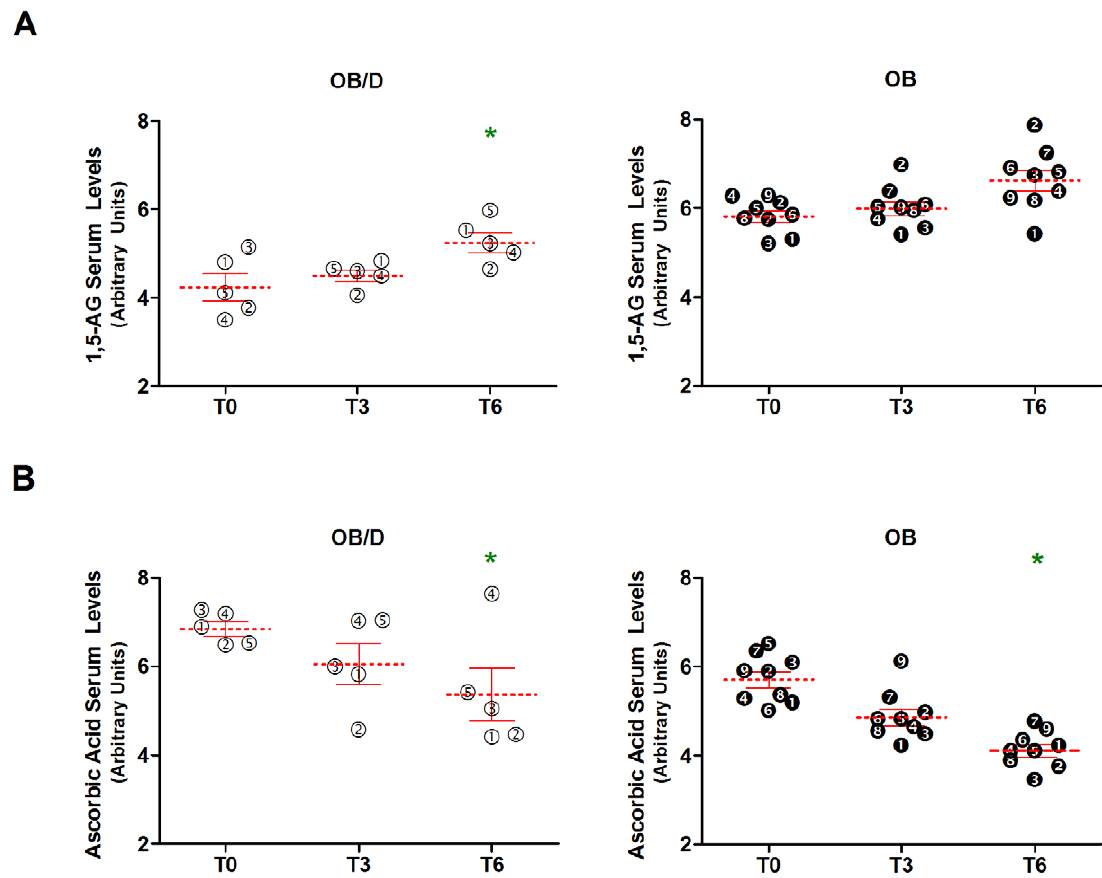
Figure 4. Increases in 1,5-anhydrosorbitol and decreases in ascorbic acid following RYGB. The top two metabolites distinguishing OB and OB/D subjects were identified with the mixed-effects ANOVA allowing for group:time-interactions, where * indicates p , 0.05 (versus T0). White circles and black circles correspond to OB/D or OB subjects, respectively. Furthermore, symbols and numbers are consistently used for the same subject in Figures 4 & 5. Mean metabolite abundance 6 SEM is indicated in red. A) A significant increase in 1,5-anhydrosorbitol (1,5-AG) occurred at T6 vs. T0 in OB/D subjects, while a non-significant increase was seen in OB subjects (group:time interaction was allowed for by the linear model). B) For ascorbic acid, the ANOVA model did not detect group-specific changes over time (no group:time interaction), but indicated significant decreases from T0 to T6 in both groups. Overall, 1,5-anhydrosorbitol and ascorbic acid were significantly different at each time point between OB and OB/D subgroups (p , 0.01, see TABLE 2 ).